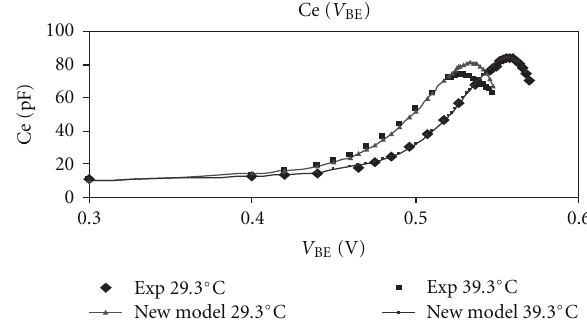
Figure 3: Experimental and simulated values of Ce at 29.3 ◦ C and 39.3 ◦ C with the new